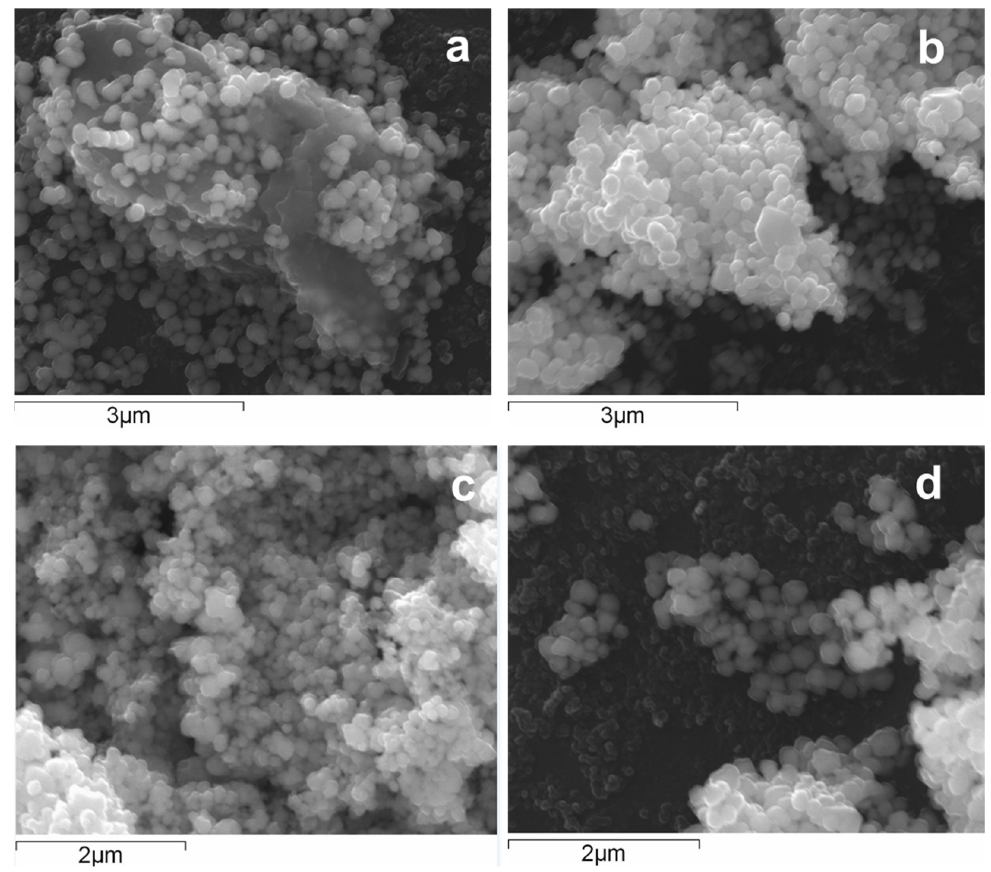
Figure 5. Scanning electron microscopy (SEM) images of metallic copper nanoparticles obtained from the reduction of Cu(II)-rich acidic solutions by ascorbic acid 0.1 M at pH 3.95 and 80 °C. ( a,b ) Sample CA; ( c , d ) Sample ST.